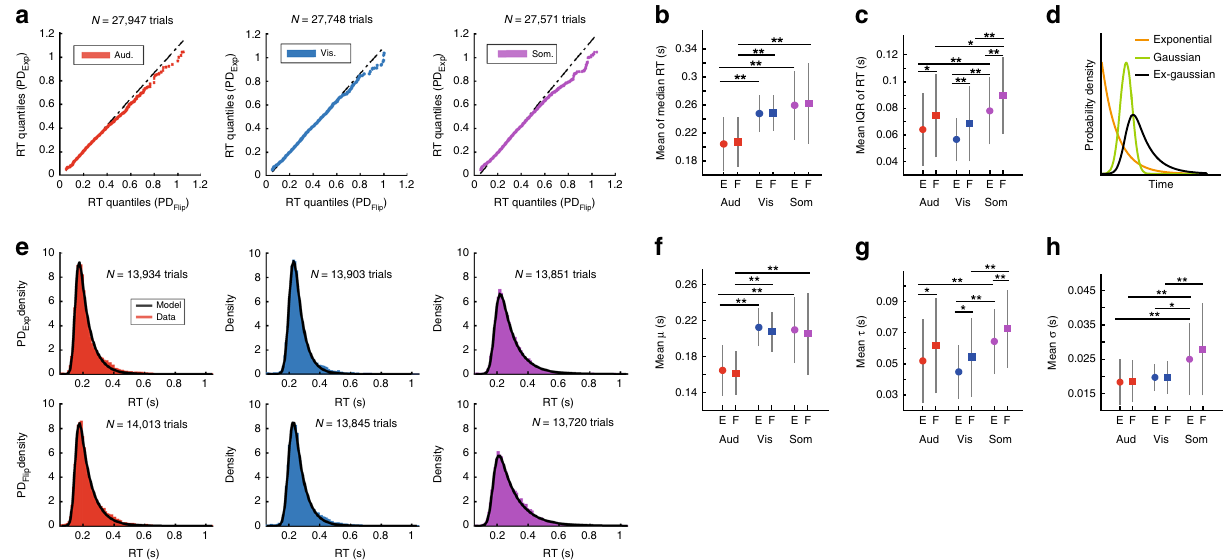
Fig. 6 Reaction time (RT) variance is sensitive to the probability distribution of events. a In all three sensory modalities, QQ-Plots reveal heavier right tails in the RT distributions in the PD Flip condition. b Mean of median RT in PD Exp ( ‘ E ’ ) and PD Flip ( ‘ F ’ ) conditions. Average RT is not sensitive to the presented probability distribution. (planned contrasts, * P < 0.05, ** P < 0.01, two-tailed Student ’ s t -test). c Mean of interquartile range of RT in PD Exp and PD Flip condition. RT variance is higher in the PD Flip condition (planned contrasts, * P < 0.05, ** P < 0.01, two-tailed Student ’ s t -test). d The Ex-Gaussian distribution is a convolution of an exponential and a Gaussian PDF. e The ex-Gaussian model fi ts RT histograms on the group level ( e ) and on the single- subject level (see Supplementary Fig. 15). f – h Ex-Gaussian fi t parameters from single-subject fi ts. f Mean of Gaussian μ resembles mean of median RT (compare to b , planned contrasts, * P < 0.05, ** P < 0.01, two-tailed Student ’ s t -test). g Mean of exponential τ resembles interquartile range of RT (compare to c , planned contrasts, * P < 0.05, ** P < 0.01, two-tailed Student ’ s t -test). h Mean of Gaussian σ is not sensitive to the presented probability